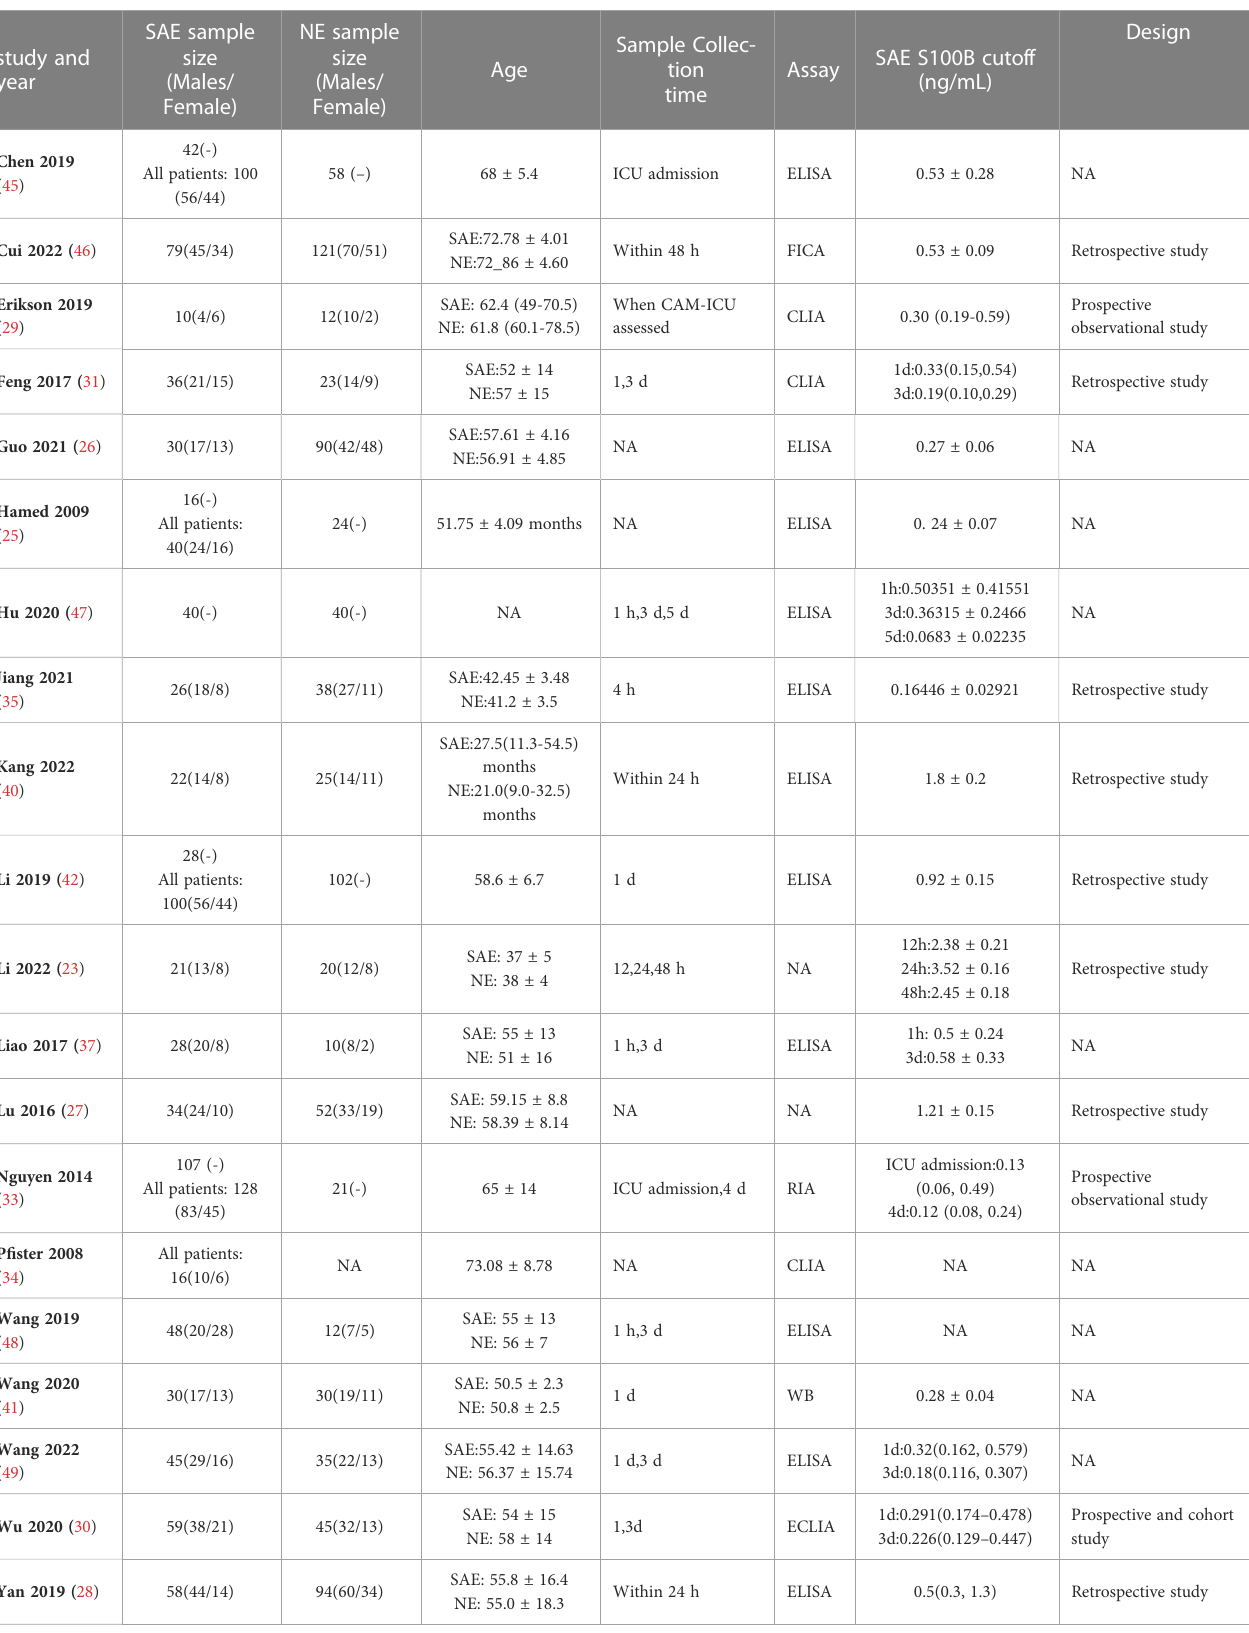
TABLE 1 Speci fi c basic characteristics of the included studies (SAE, Sepsis-associated encephalopathy patients; NE, no − encephalopathy septic patients; NA, not announce; h, hour; d, day; m, month; ELISA, enzyme-linked immunosorbent assay; ECLIA, electrochemiluminescence immunoassay; CLIA, chemiluminescence immunoassay; ICA, immunochromatography assay; FICA, fl uorescence immunochromatography assay; RIA, radioimmunoassay; WB, western